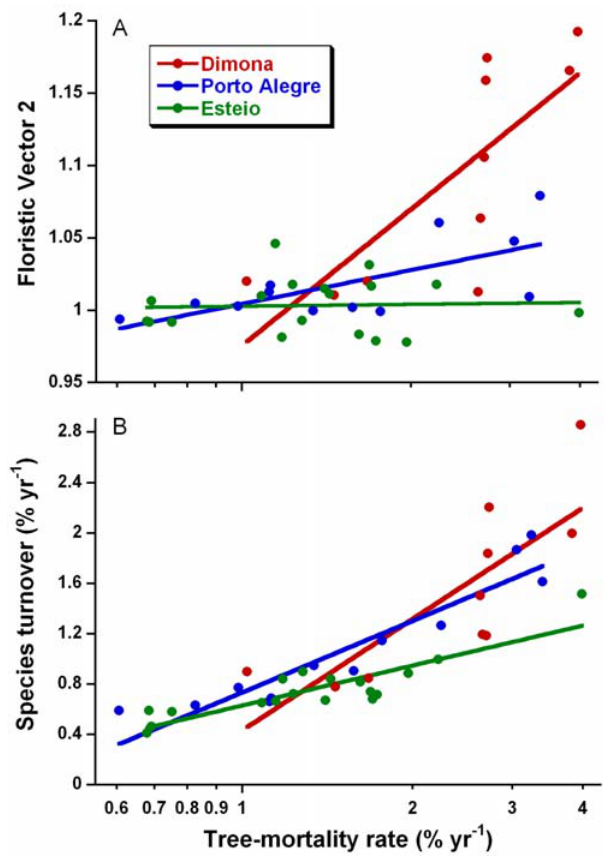
Figure 3. Ecological differences among forest fragments in three Amazonian cattle ranches. Differences among the ranches are shown for (A) floristic change (floristic vector 2) and (B) tree-species turnover, using the mean tree-mortality rate in each plot as a